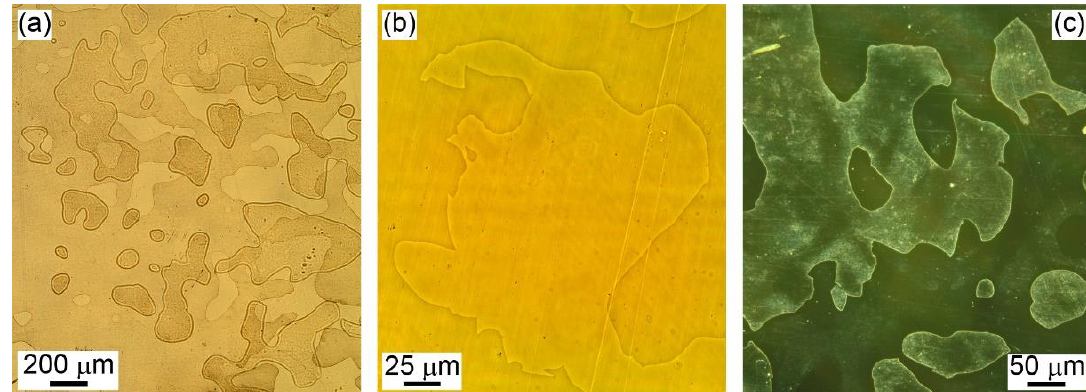
Figure 2. Optical images of as-grown domain structure in ( a ) nominally pure, ( b ) 0.05% Mn-doped, and ( c ) 0.1% Mn-doped CVO single crystals. Transmitted light: ( a ) bright field, ( b ) phase contrast, ( c ) dark field.